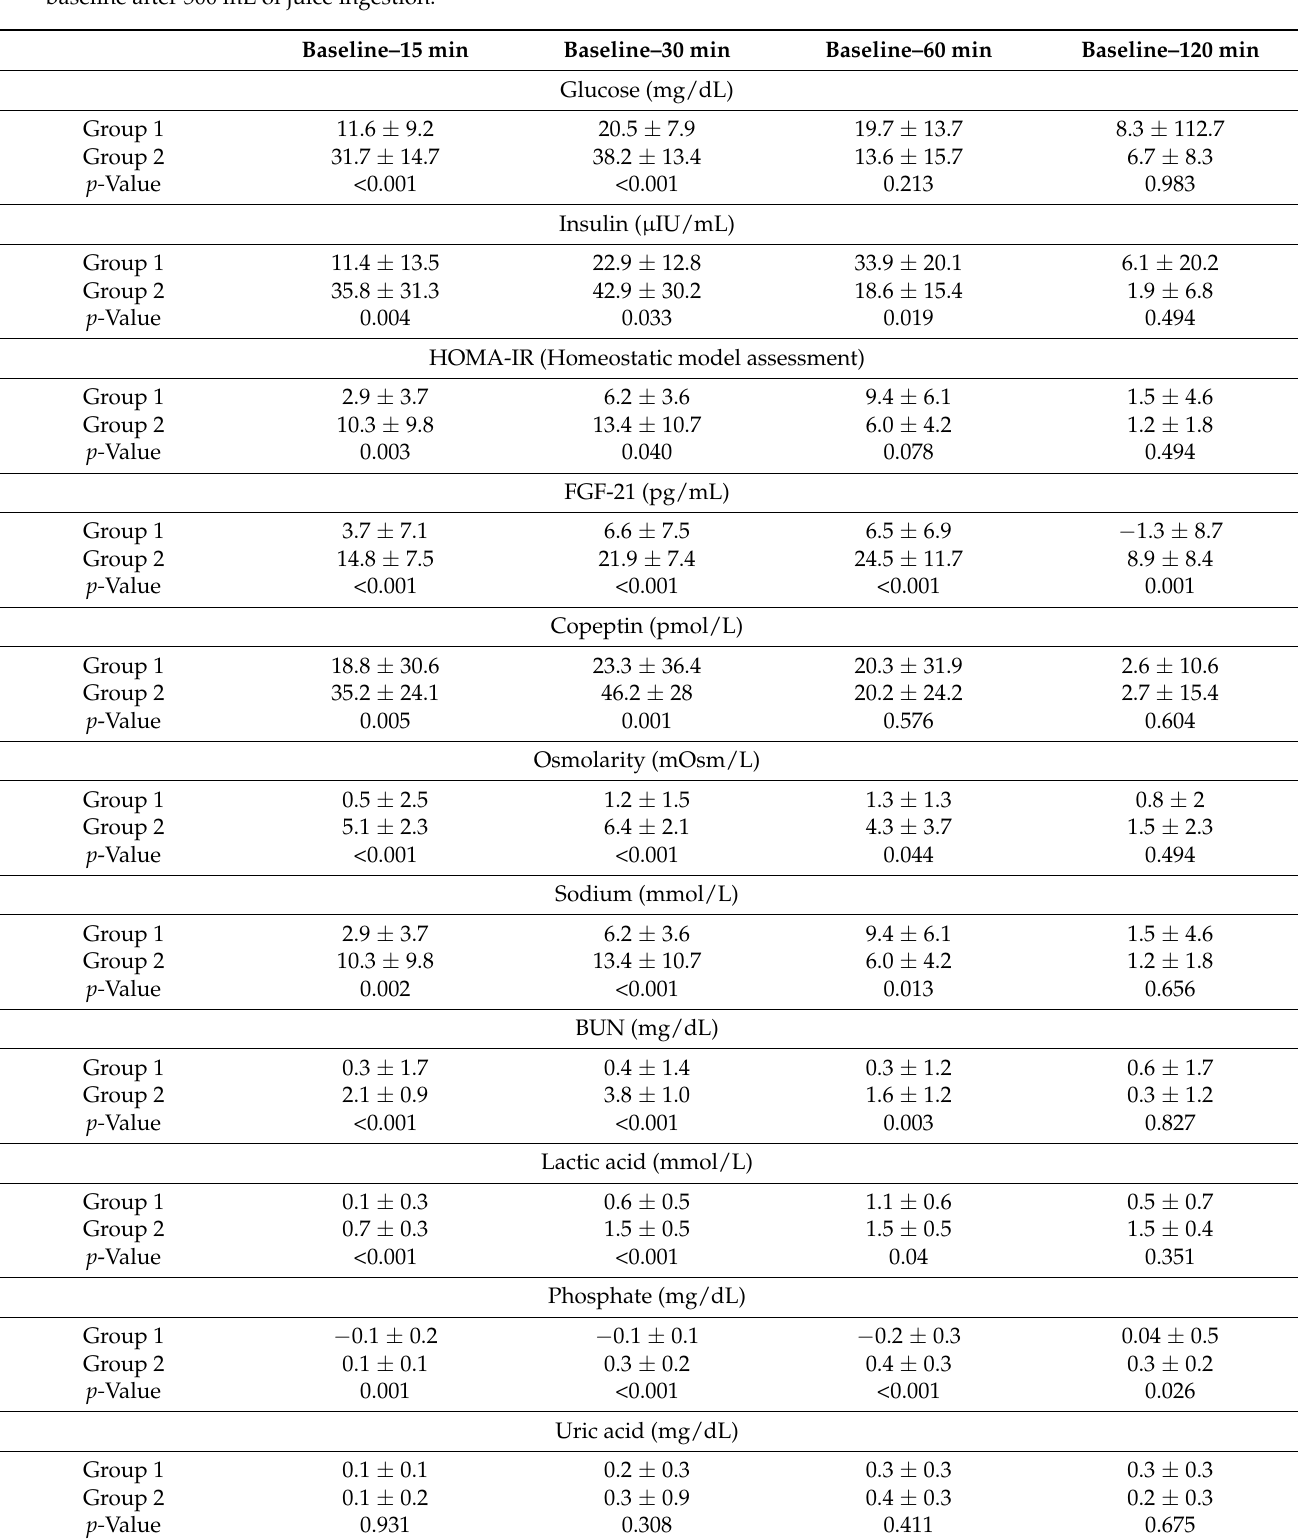
Table 3. The differences in glucose, insulin, HOMA-IR (homeostatic model assessment) score, FGF-21 (fibroblast growth factor), copeptin, osmolarity, sodium, BUN (blood urea nitrogen), lactate, uric acid, and phosphate levels compared with baseline after 500 mL of juice